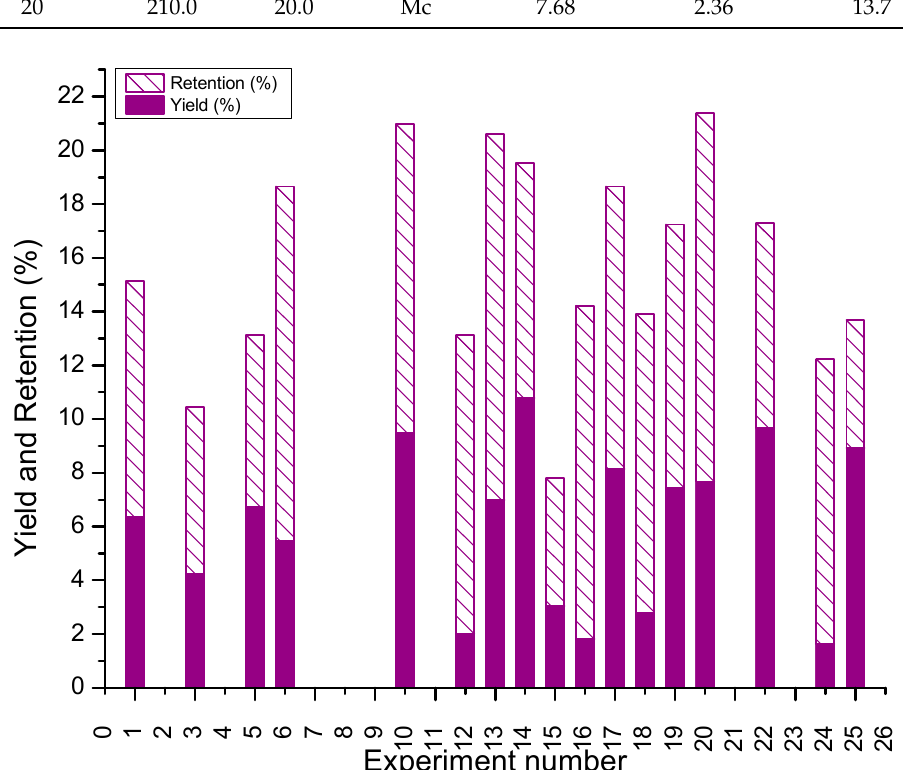
Figure 4. Yield (%), and retention (%) of quercetin 3- D -galactoside obtained for the 25 runs. The missing bars indicate the runs where sample collapsed during the spray drying process.